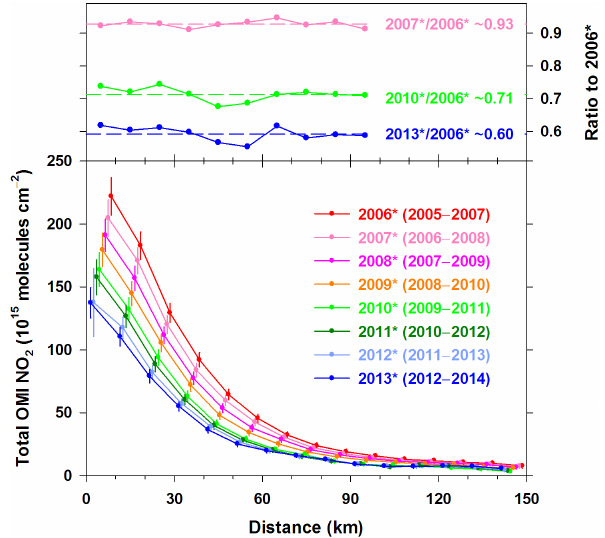
Figure 8. The sum of 3-year averaged OMI NO 2 TVCDs under the weak-wind-speed condition for 35 selected US urban areas as a function of the distance from the urban centers during 2006*– 2013*. The background NO 2 of urban areas was removed. Er- ror bars express the 95% confidence intervals of the mean. The 2007*/2006*, 2010*/2006*, and 2013*/2006* ratios are shown at the